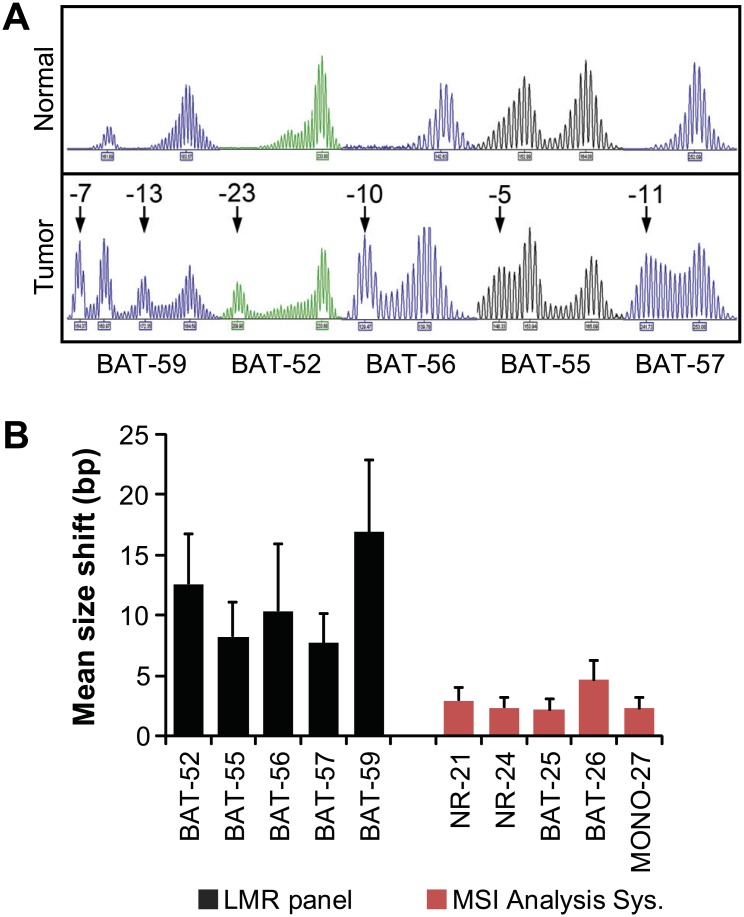
Use of LMR markers for MSI analysis typically resulted in larger allele size changes in MSI-High lesions.(A) Electropherogram of MSH2-deficient tumor sample 267B and matching normal tissue screened for MSI using the experimental LMR panel which shows all five markers were unstable with size shifts of up to 24bp. (B) The average change in tumor allele size of MSI-High lesions was determined for the markers in the LMR panel and the MSI Analysis System. The average size shift was significantly greater in LMR markers (p = 0.0014), which increased confidence in MSI classification. Error bars show standard error of the mean.